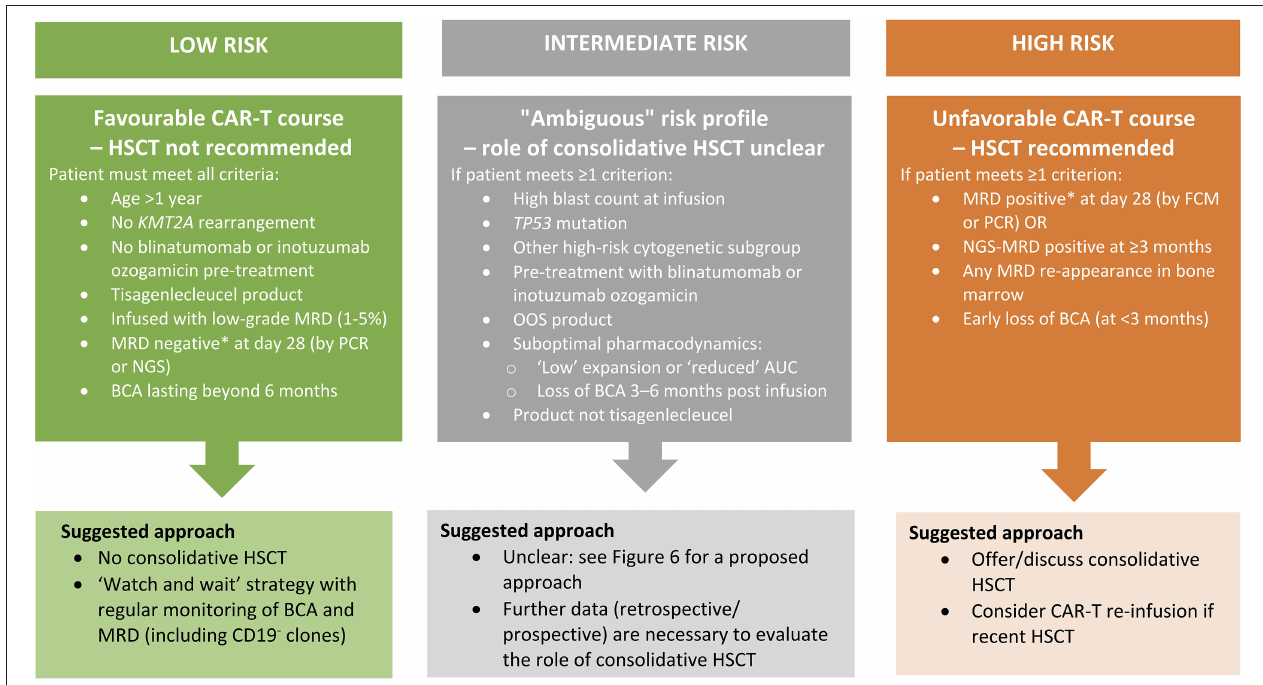
FIGURE 5 | Proposed approach to HSCT consolidation after CAR-T for paediatric patients and AYA with BCP-ALL based on treatment- and disease-related risk factors for relapse. *MRD positivity defined at > 0.01%. AUC, area under the curve; AYA, adolescent and young adult; BCA, B-cell aplasia; CAR-T, chimeric antigen